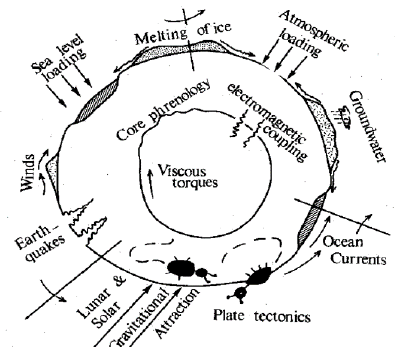
Figure 1. The forces that affect the earth rotation and the coordinate system (Dickey,